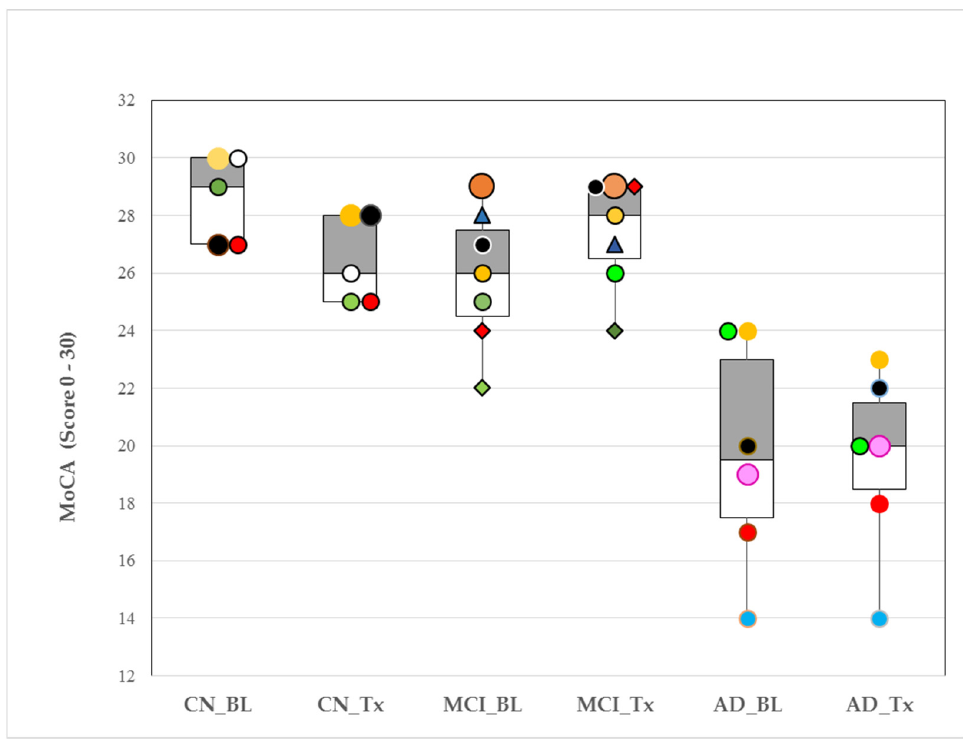
Figure 1. Box plots of medians and interquartile ranges (25th–75th percentiles) for Montreal cogni- tive assessment (MoCA) responses to oral appliance therapy (OAT) after 4 weeks in cognitively normal (CN), mild cognitive impairment (MCI) and Alzheimer’s disease (AD). Pre-OAT (baseline, BL); after 4 weeks (Tx, with OAT). p -values for within-group changes for CN, MCI and AD samples were 0.05, 0.20 and 0.642, respectively. MoCA normal range: >26–30. Colors and symbols identify individuals within group at baseline and their response to Tx. (Example: CN_BL ‘black circle’ sub- ject (MoCA score = 27) increased their MoCA score to 28 with Tx).